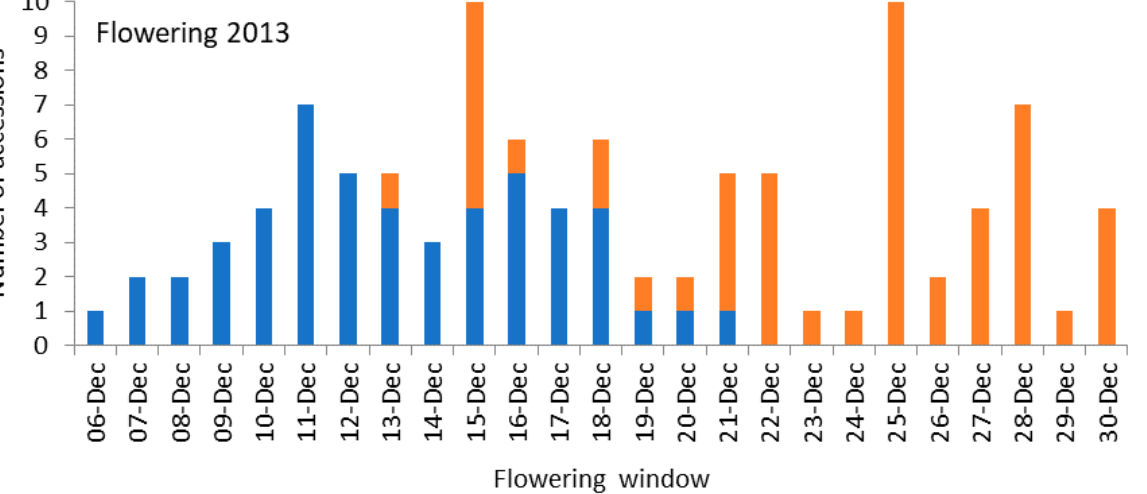
Figure 6. Histogram of time to 50% fl owering for Chadian dry-season sorghum accessions sown early (blue bars) and late (red bars) in 2013 at the Youé research farms in Chad.